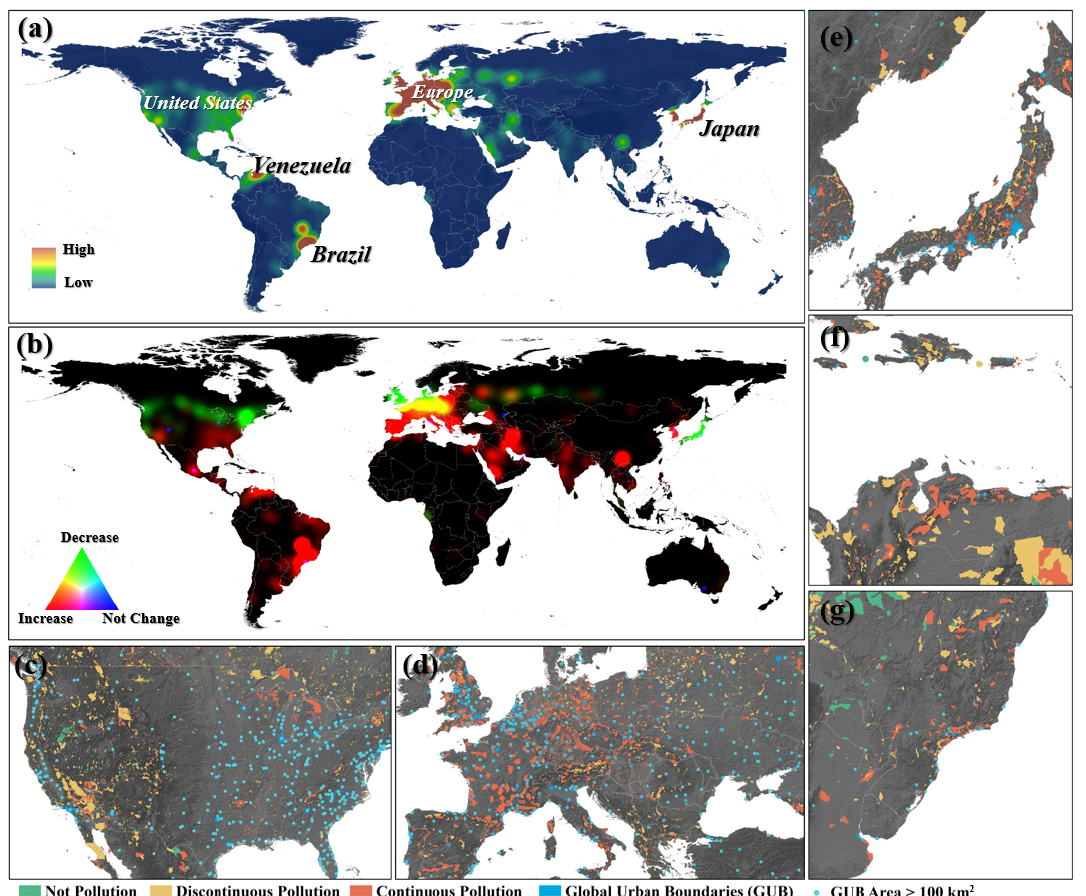
Figure 7. Distribution of global polluted PAs with high value of NTL in the high-intensity interval ( a ) and their temporal trends of NTL over the past decades ( b ). Detailed cases in ( c – g ) in ( a ) can be found in enlarged views. Note: the mean value of NTL and temporal trend of annual NTL sum in the high-intensity interval were visualized by the kernel density approach to identify these five global hotspots.